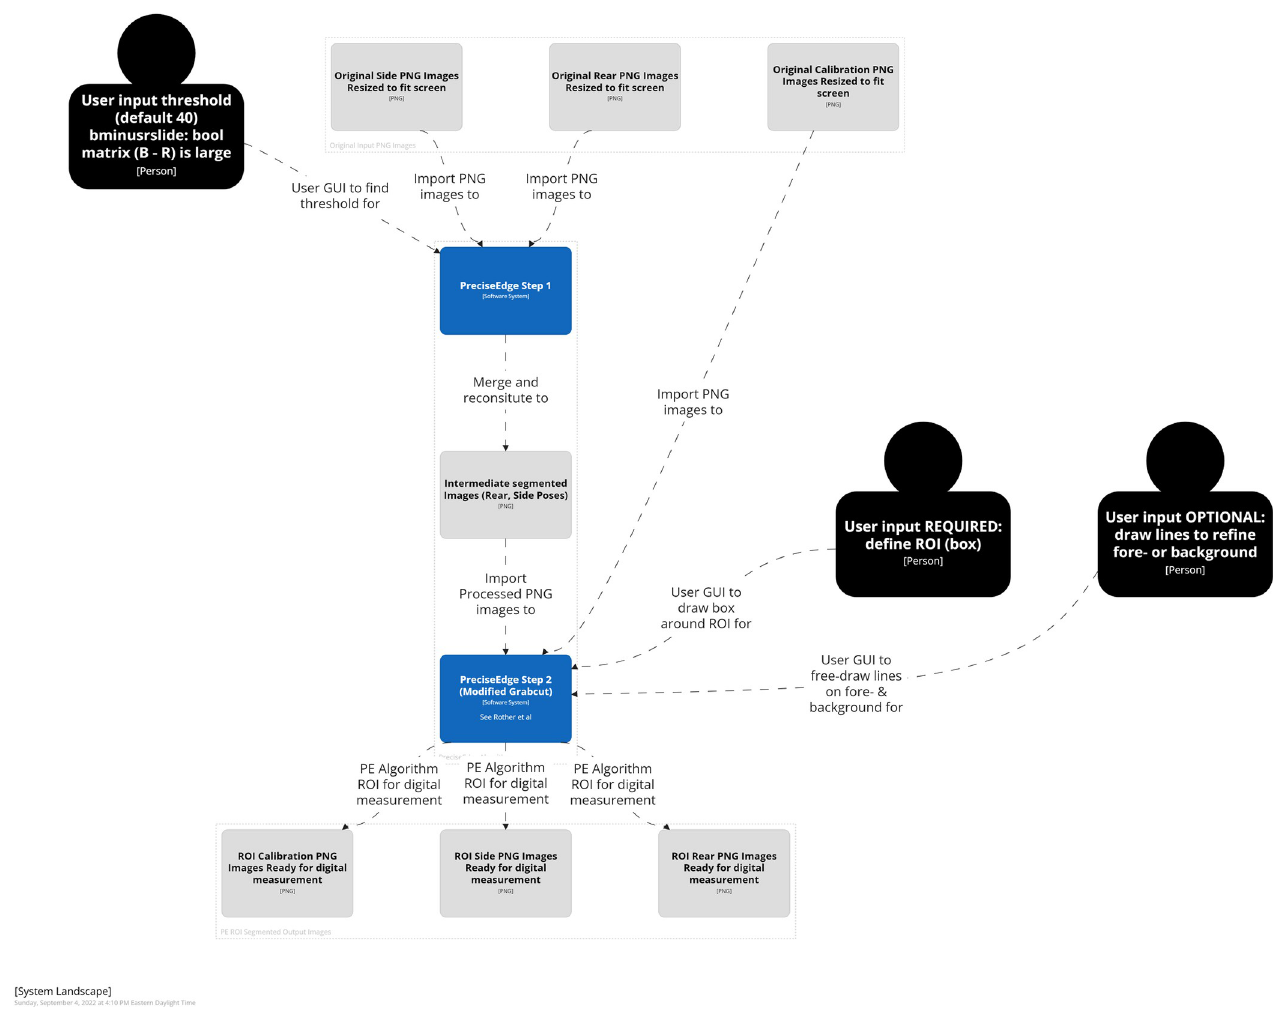
Fig 2. PreciseEdge algorithm